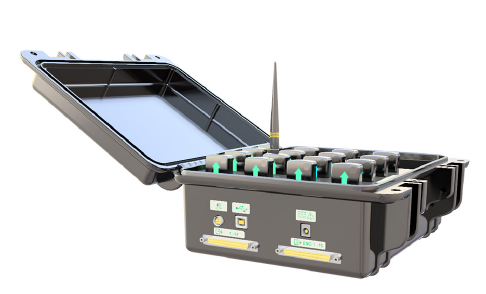
Figure 6. Delsys Trigno